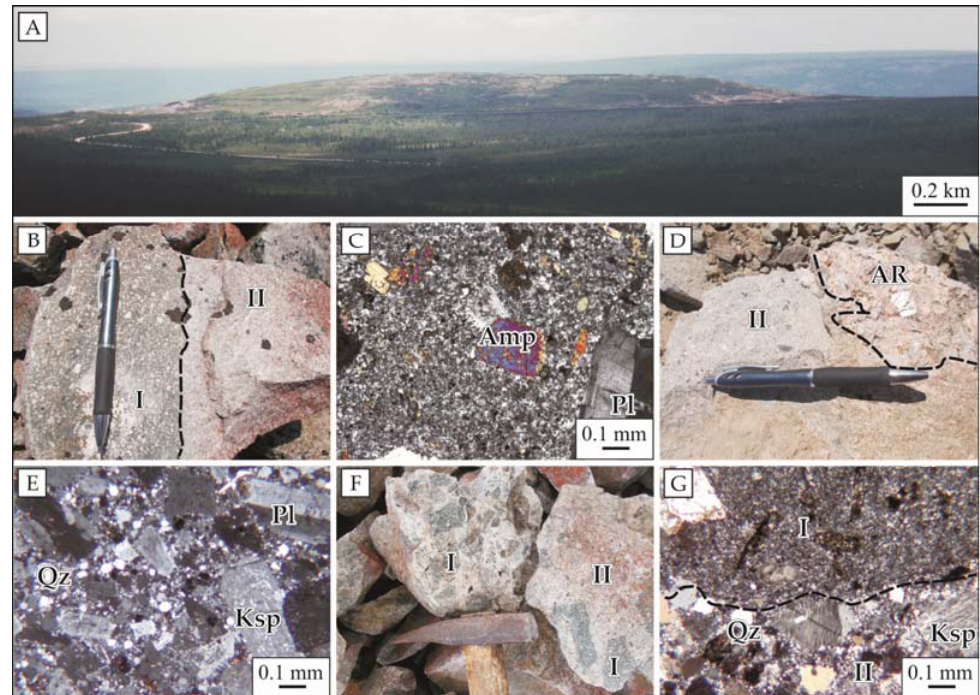
Figure 3. General view and petrography of rocks of the Taezhniy massif. Rocks involved in the structure of the Taezhniy massif: I—quartz monzonites, II—syenite, AR—Precambrian host rocks of basement, Qz—quartz, Amp—amphibole, Pl—plagioclase, Kfs—potassium feldspar, Cpx—clinopyroxene; ( A ) general view of Taezhniy massif; ( B ) contact between two phases of massif; ( C ) thin section I19–24/2, phenocrysts Amp and zoned Pl in quartz monzonites of Taezhniy massif, mag. 40x, crossed nicols; ( D ) contact between rocks of second phase and Precambrian host rocks of basement; ( E ) thin section I19–27/6, pelitized Kfs in syenite, mag. 40x, nicols +; ( F ) xenoliths of monzonites (I phase) in syenite, mag. 10x, nicols +; ( G ) thin section I19–24, xenolith of monzonites (I phase) in syenite, mag. 10x, nicols +.